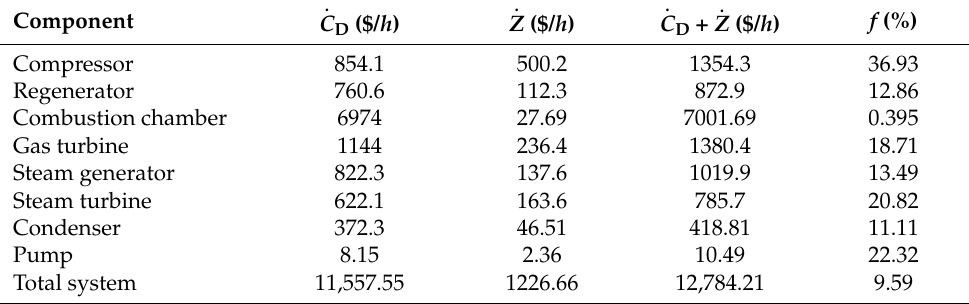
Table 13. Exergoeconomic analysis of Config. 2.